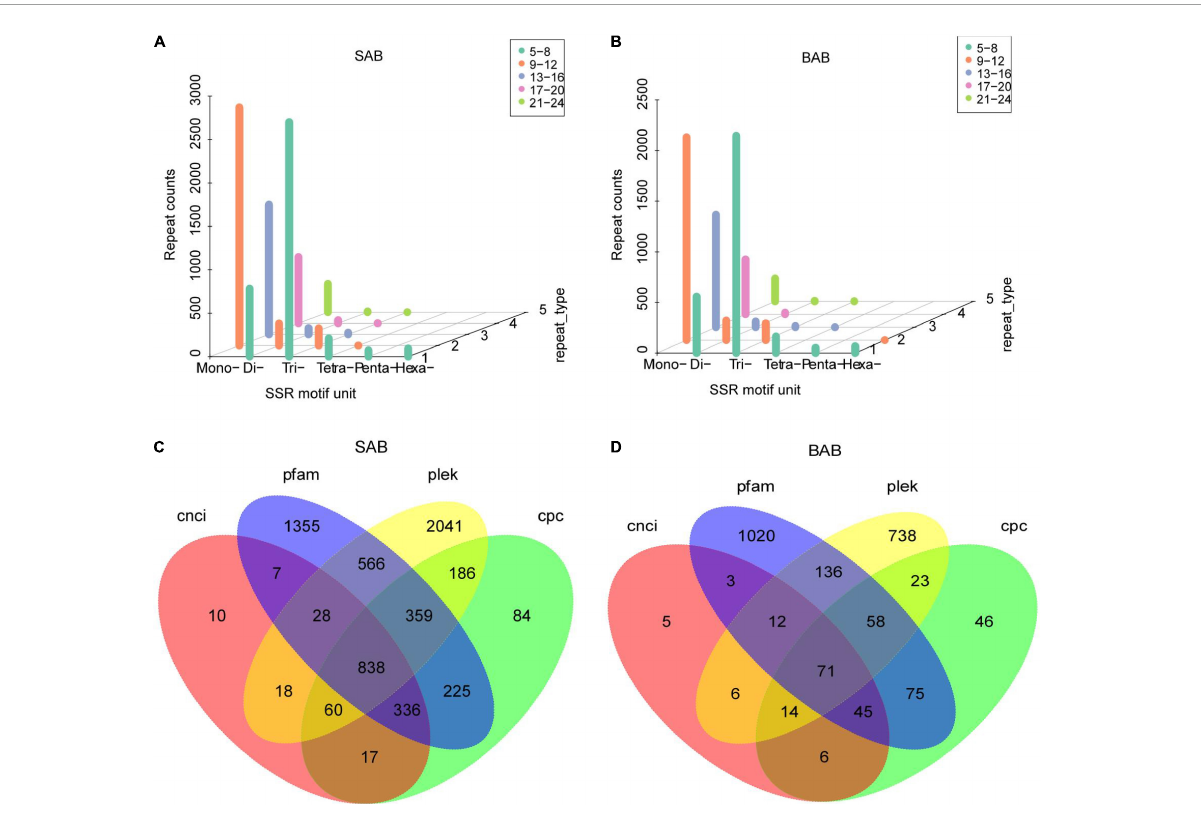
FIGURE4 SSR analysis and forecasting for LncRNA. (A) SSR analysis of H. ammodendron ; (B) SSR analysis of H. persicum ; (C) Venn diagram of prediction results of LncRNA of H. ammodendron ; and (D) Venn diagram of prediction results of LncRNA of H. persicum . SAB and BAB are the names of mixed samples of H. ammodendron and H. persicum under two soil moisture conditions; LS and LB, respectively, represent H. ammodendron and H. persicum in an arid environment; HS and HB denote H. ammodendron and H. persicum , respectively, under a humid